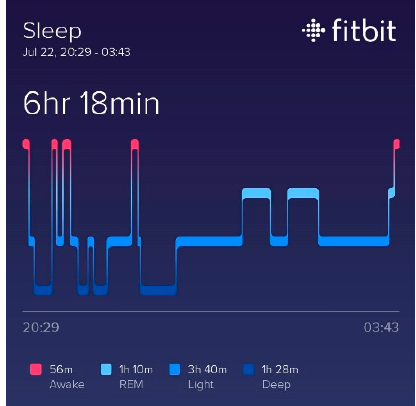
Figure A28. Taipei,